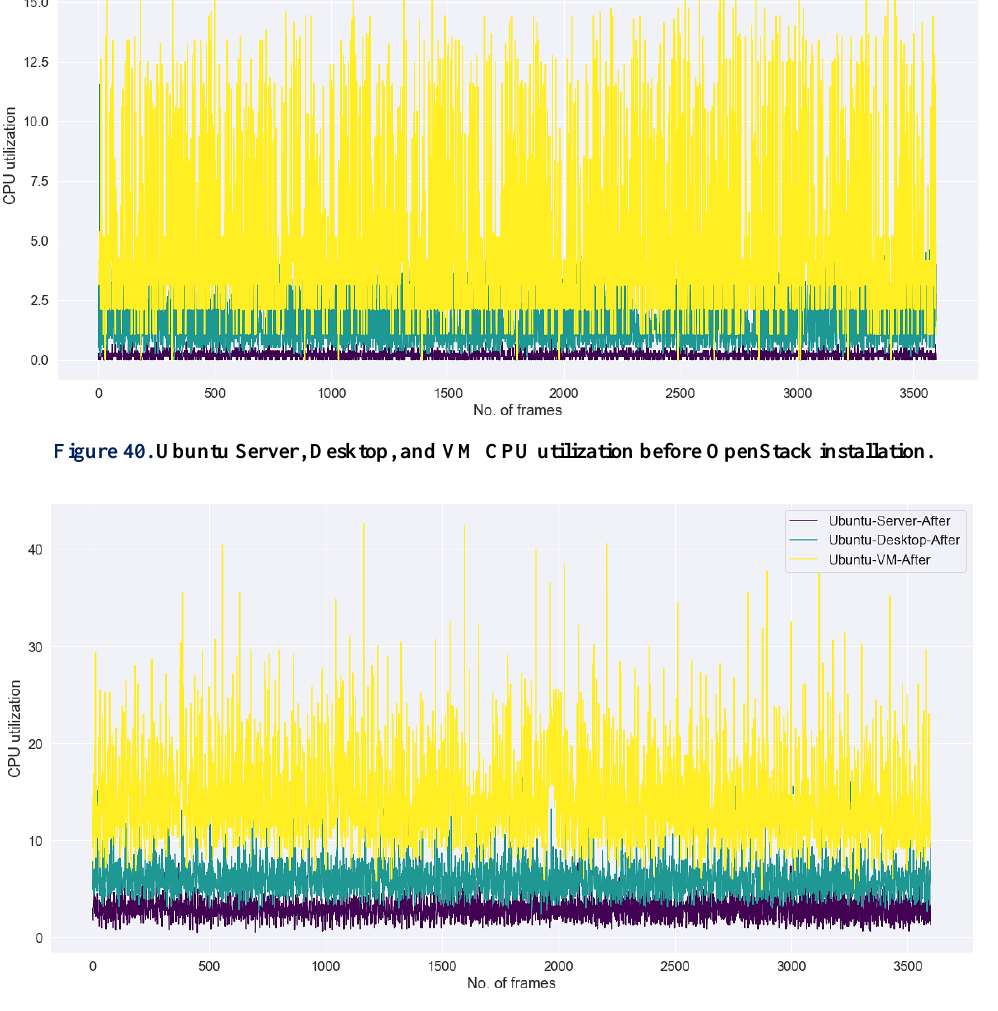
Figure 41. Ubuntu Server, Desktop, and VM CPU utilization after OpenStack